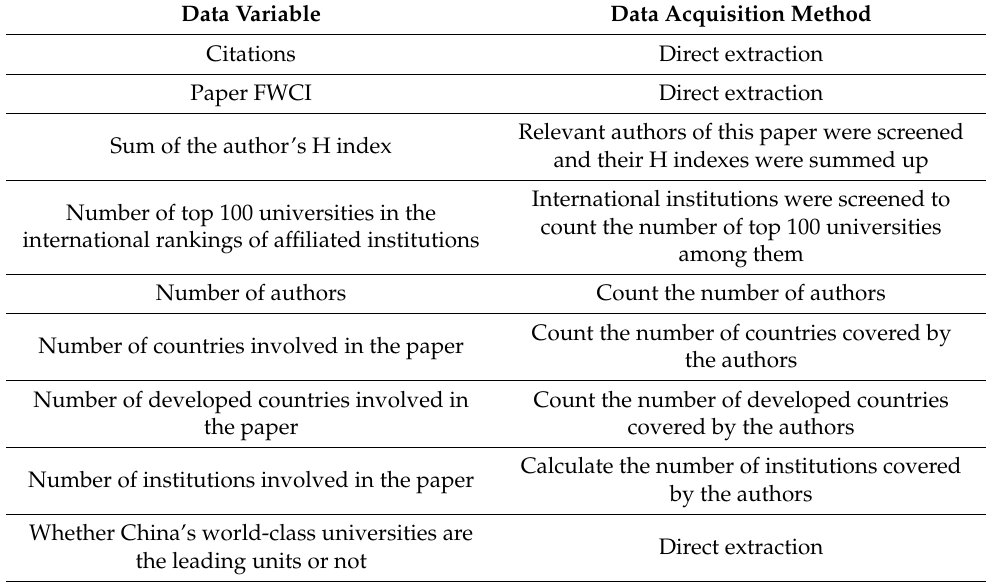
Table 1. Data acquisition and calculation